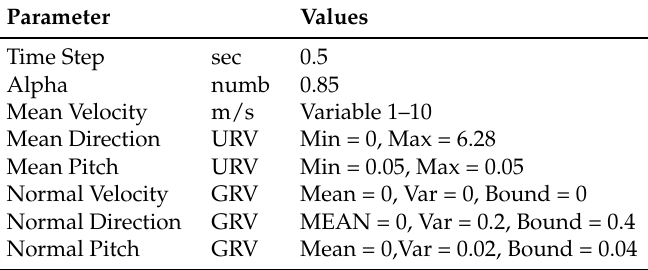
Table 6. Parameters set in the Gauss–Markov model for a random flight pattern of a UAV. Parameter Values Time Step sec 0.5